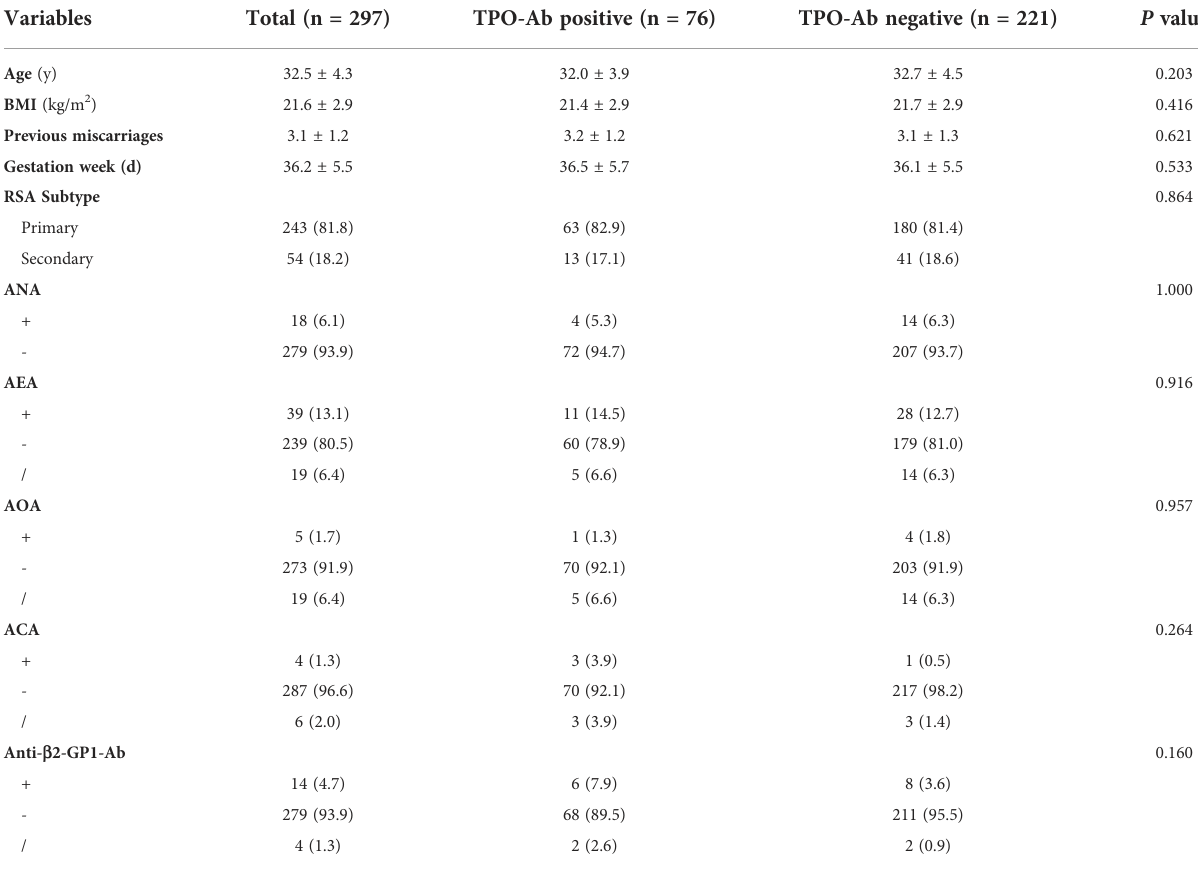
TABLE 1 Comparison of baseline characteristics and autoimmune antibodies in euthyroid women with URSA.